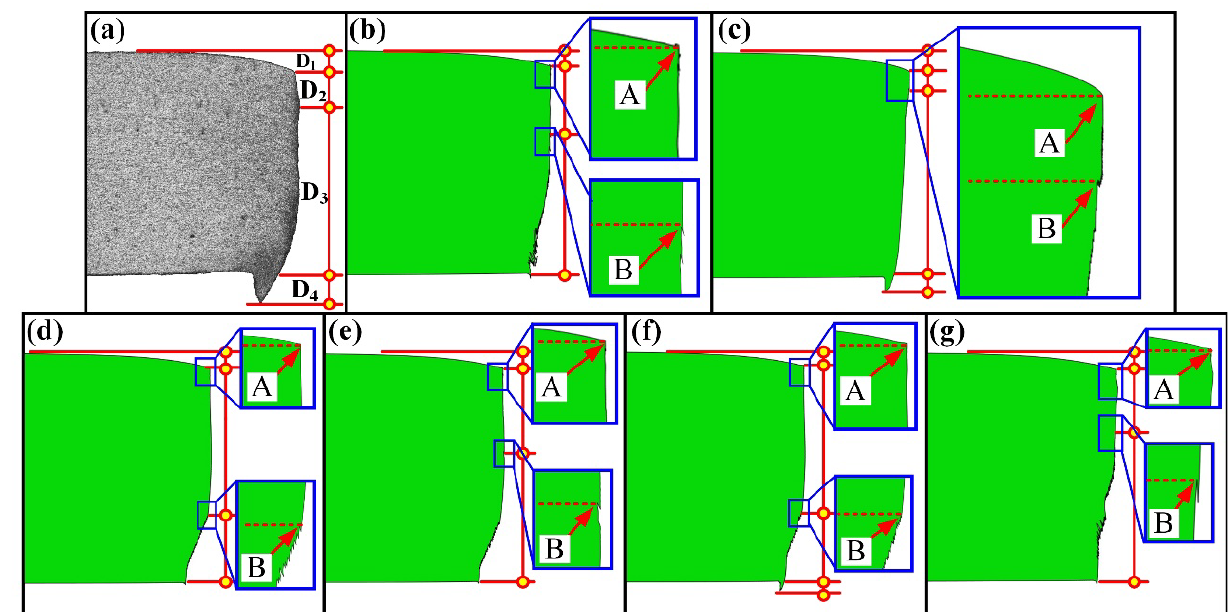
Figure 23. The morphology of sheared edge obtained under the shearing clearance of 5%t. ( a ) Ex- perimental results. ( b ) Simulation results of Freudenthal model. ( c ) Cockcroft and Latham model. ( d ) Rice and Tracey model. ( e ) Brozzeo model. ( f ) Oh model. ( g ) Oyane-Sato model.